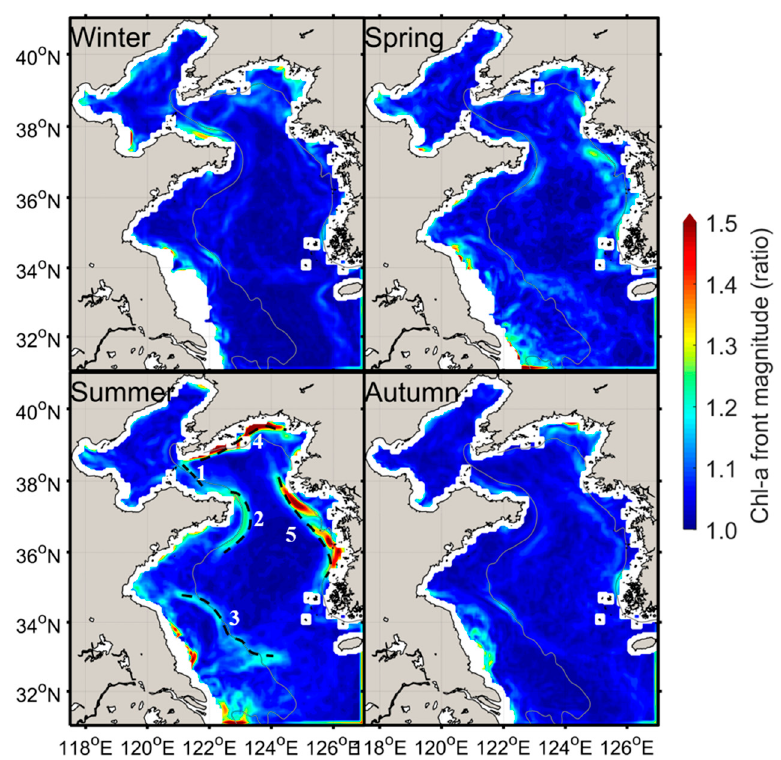
Figure 4. Seasonal chl-a front magnitudes (expressed as ratios). Five chl-a fronts in summer: 1, Bohai strait (BS) front; 2, Shandong Peninsula (SP) front; 3, Jiangsu (JS) front; 4, Liaodong Peninsula (LP) front; 5, Korean Peninsula (KP) front. The gray lines denote the 40 m isobath.